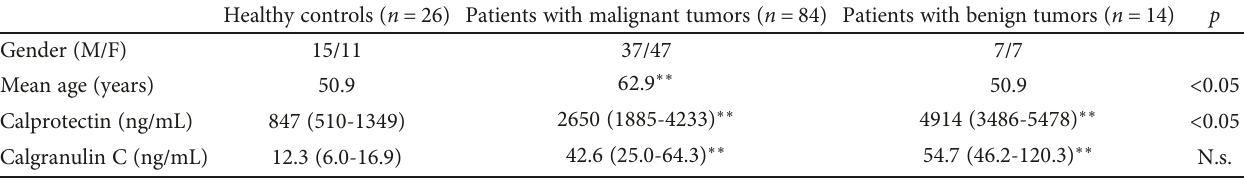
Table 2: Baseline characteristics of patients with malignant and benign tumors and healthy controls and their comparisons. Healthy controls ( n = 26 ) Patients with malignant tumors ( n = 84 ) Patients with benign tumors ( n = 14